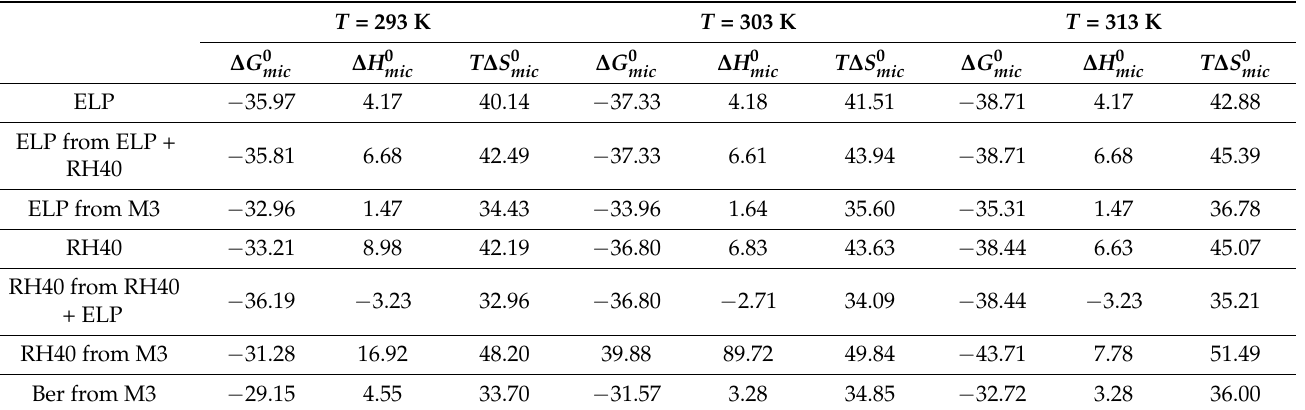
Table 5. Thermodynamic parameters of the micellization process of ELP, RH40, and Ber